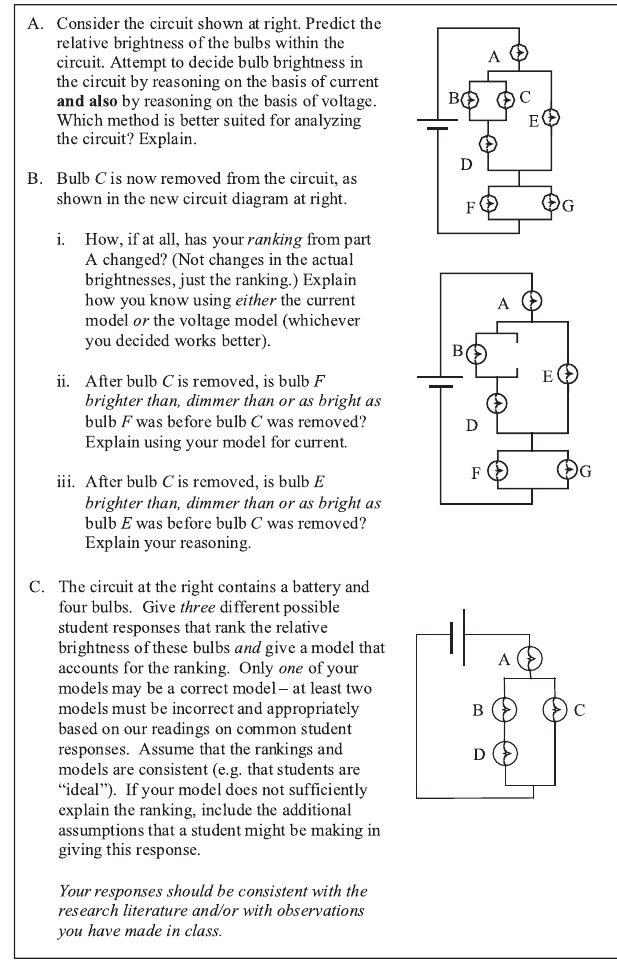
FIG. 2. Posttest questions for content (A), (B) and KSI (C) for electric circuits. (A) is based on a homework question in Physics by Inquiry [8]; (C) is based on unpublished posttest data. The instructions in italics at the bottom were not included until the third time the course was taught. [Correct KSI responses to question (C) are shown in Figs. 6 and